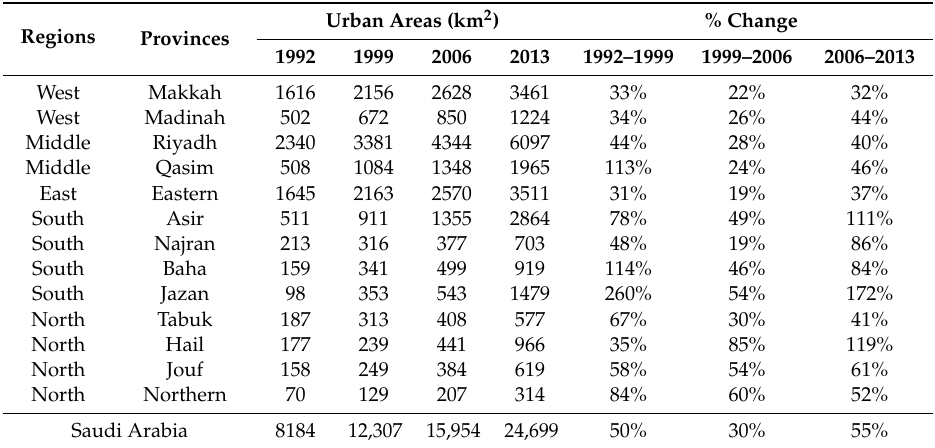
Table 4. Urban expansion in km 2 and percentage change across the three time periods for the 13 Saudi provinces and Saudi Arabia as a